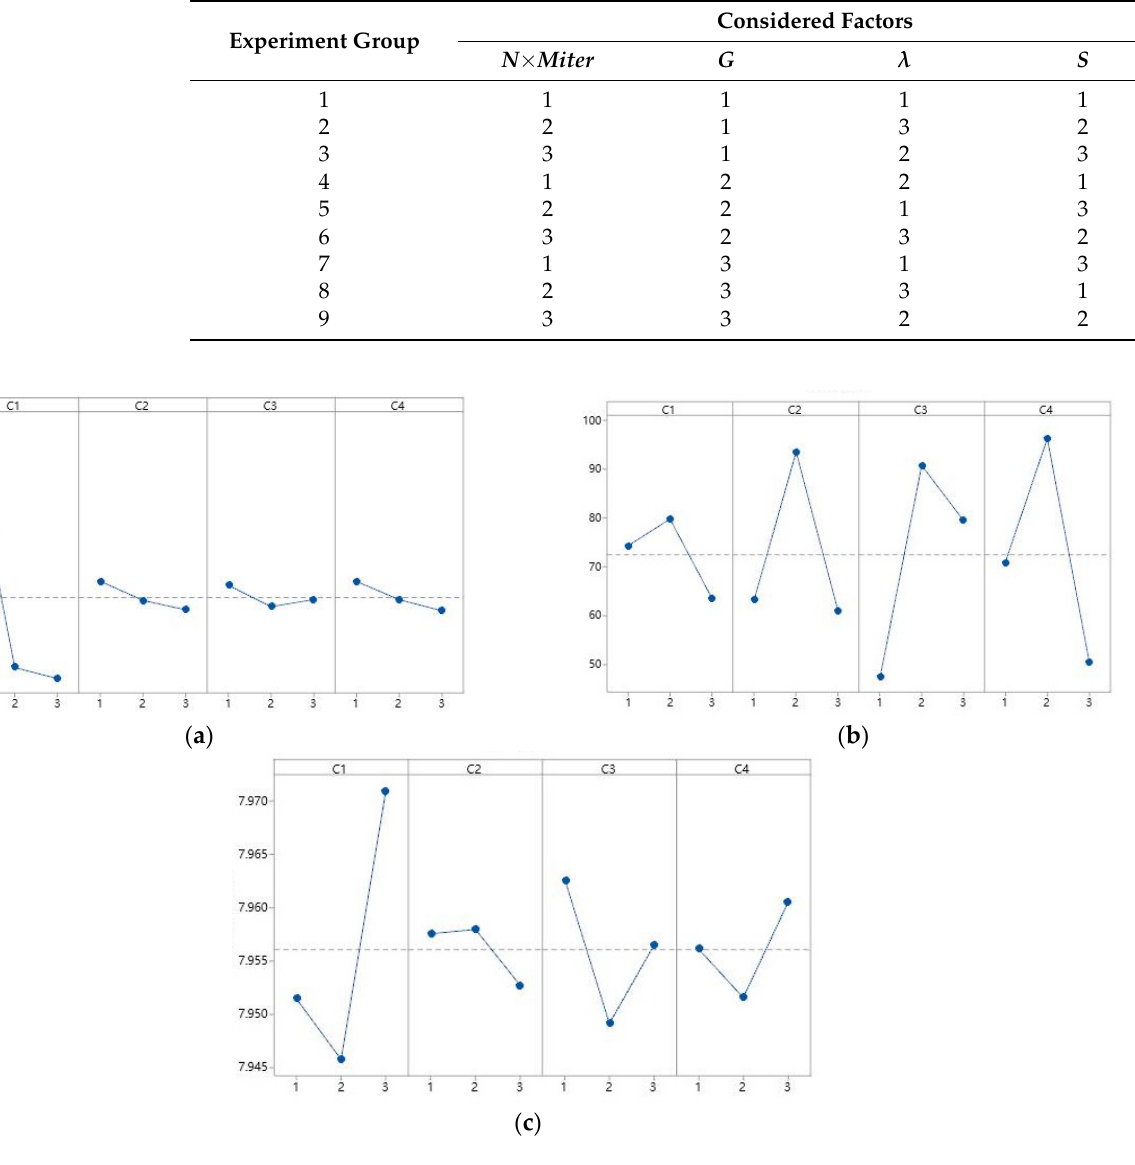
Figure 5. Signal-to-noise ratio main effect map: ( a ) the SNR main effect graph of unimodal function F 2 ; ( b ) the SNR main effect graph of multimodal function F 12 ; ( c ) the SNR main effect graph of complex function F 18